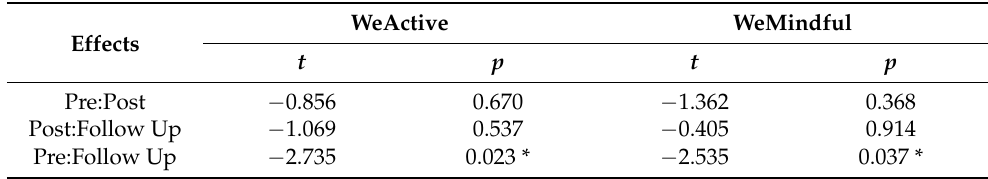
Table 8. Results of post hoc for resilience by group.